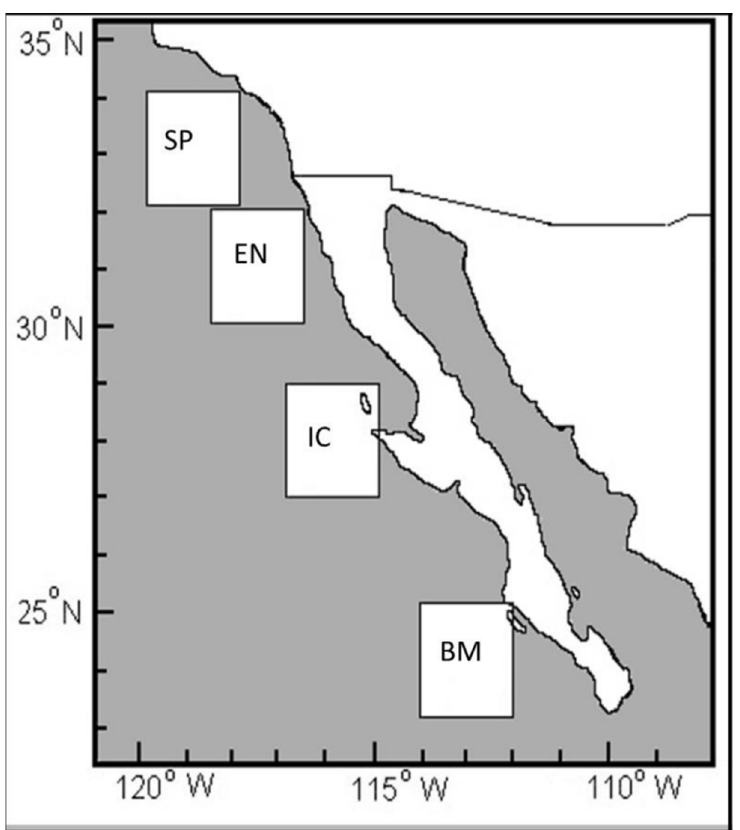
Figure 1. Map of the study area showing the distribution of the temperate stock Pacific sardine ( Sardinops sagax ). BM (Bahía Magdalena); IC (Isla Cedros); EN (Ensenada); SP (San Pedro). ( Sardinops sagax ). BM (Bah í a Magdalena); IC (Isla Cedros); EN (Ensenada); SP (San